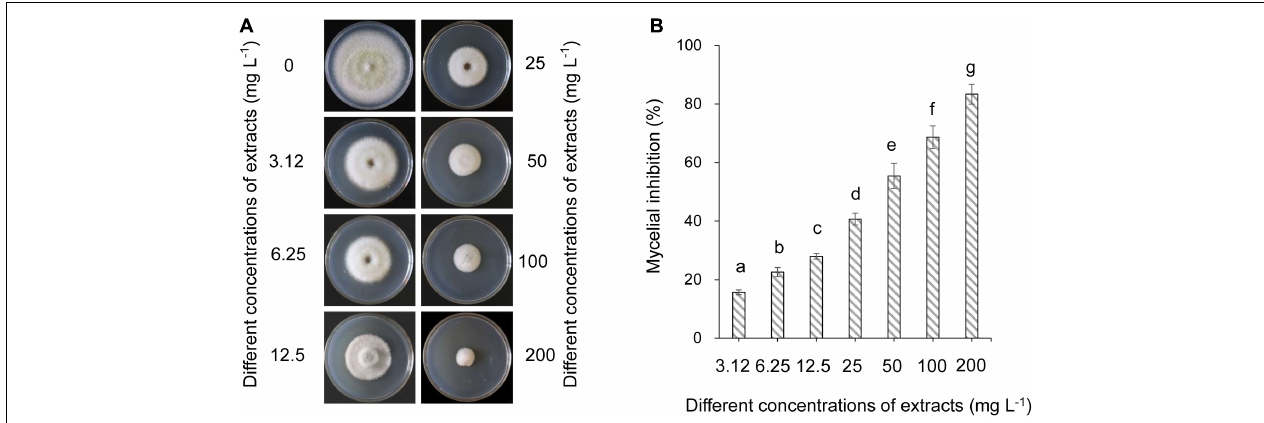
FIGURE 3 | Determination of the half-maximal effective concentration value of extract against C. fragariae . (A) Growth inhibition of C. fragariae on the PDA medium after treatment with different dose extracts. (B) Quantitative analysis of C. fragariae growth diameters. Error bars indicated standard errors of the means of three repeated experiments. Different lowercase letters represented a significant difference ( p < 0.05) of mycelial growth diameter at the same time point using the LSD multiple-range test.